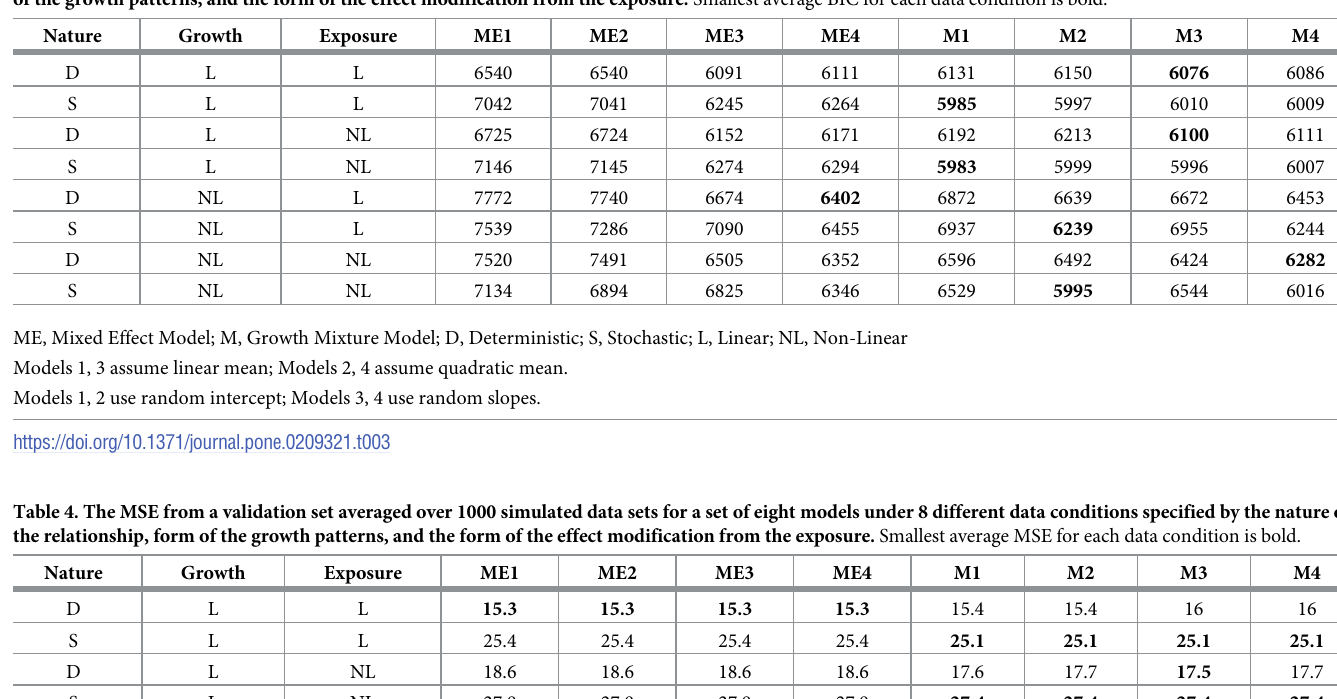
Table 3. The BIC averaged over 1000 simulated data sets for a set of eight models under 8 different data conditions specified by the nature of the relationship, form of the growth patterns, and the form of the effect modification from the exposure. Smallest average BIC for each data condition is bold. Nature Growth Exposure